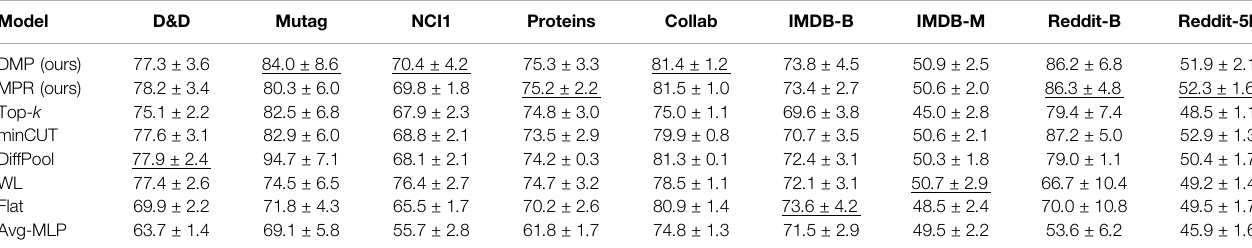
TABLE 1 | Results obtained on classi fi cation benchmarks. Accuracy measures with 95% con fi dence intervals are reported. The highest result is bolded and the second highestisunderlined.The fi rstcolumnsfouraremoleculargraphs,whiletheothersaresocialgraphs.Ourmodelsperformcompetitivelywithotherstateoftheartmodels.